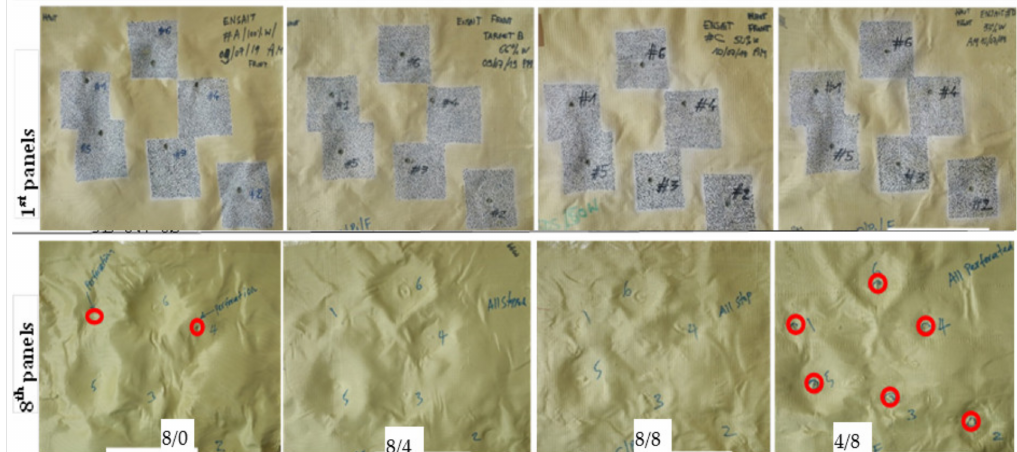
Figure 4. The striking faces of the 1st and 8th (last) panel of the tested armour systems with various shot